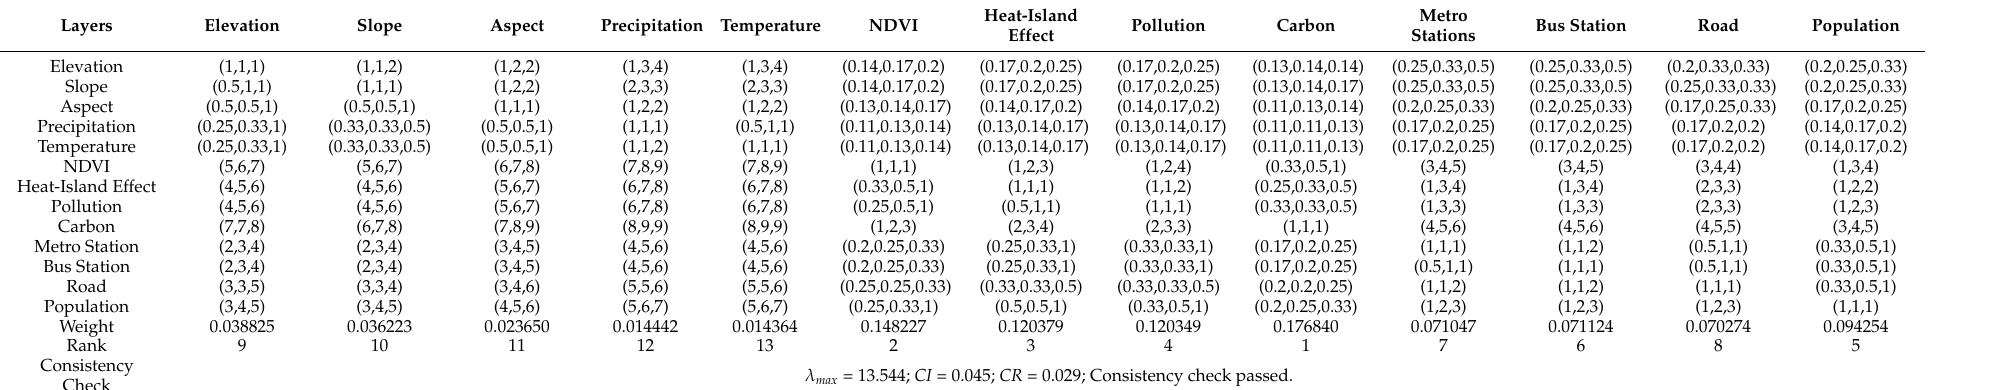
Table 3. Calculated fuzzy aggregated decision matrix of criteria and the normalized priority